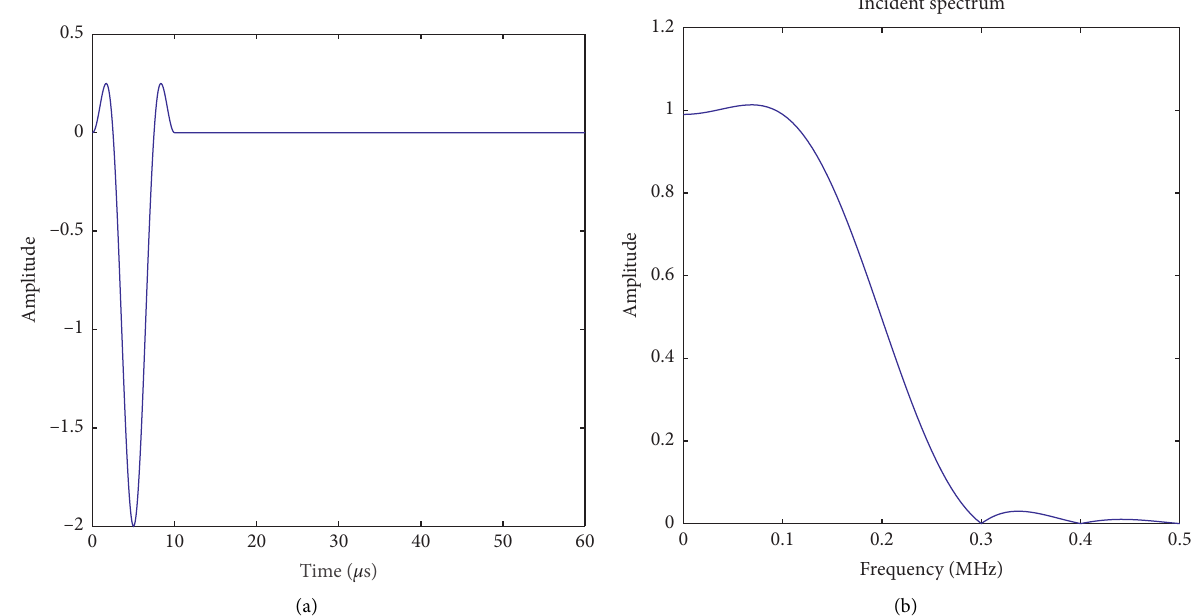
Figure 5: Broadband excitation signal: (a) A-scan waveform and (b) its